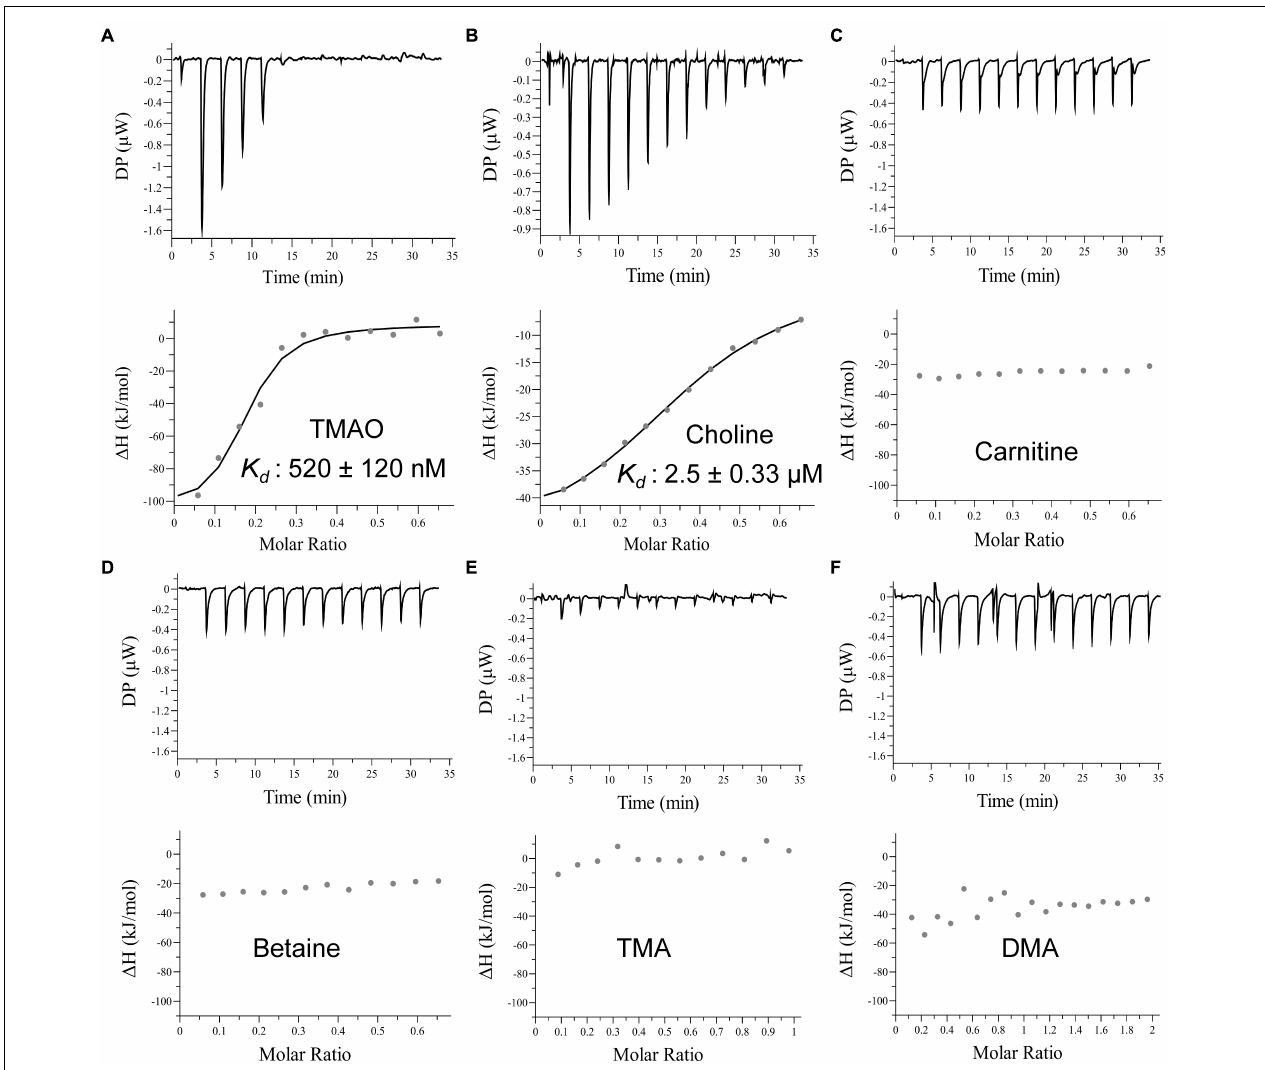
FIGURE 4 | ITC data for titrations of different substrates into TmoX 1062 . ITC traces (top) and integrated binding isotherms (bottom) are shown. Substrates are shown in each integrated binding